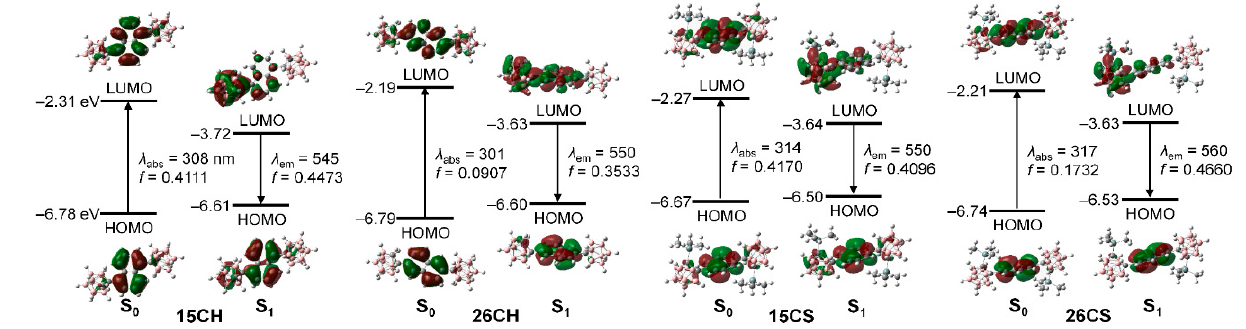
Figure 3. Frontier molecular orbitals for 15CH , 26CH , 15CS , and 26CS at their ground state (S 0 ) and the first excited singlet state (S 1 ) with their relative energies from DFT calculation (isovalue 0.04). The transition energy (in nm) was calculated using the TD-B3LYP method with 6-31G(d,p) basis sets.